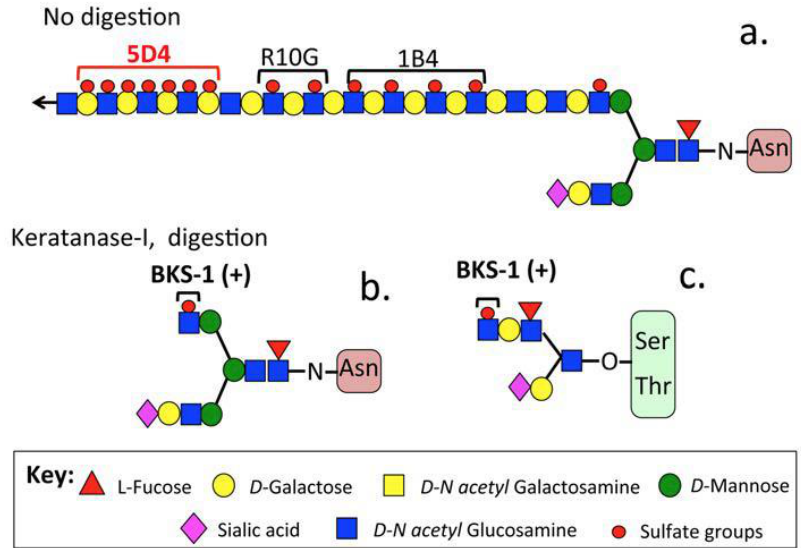
Figure 1. Structure of a typical KS-I chain and identification of high charge density 5-D-4 and low charge density R10G and 1-B-4 antibody binding sites ( a ) in N- ( b ) and O-linked KS chains ( c ).